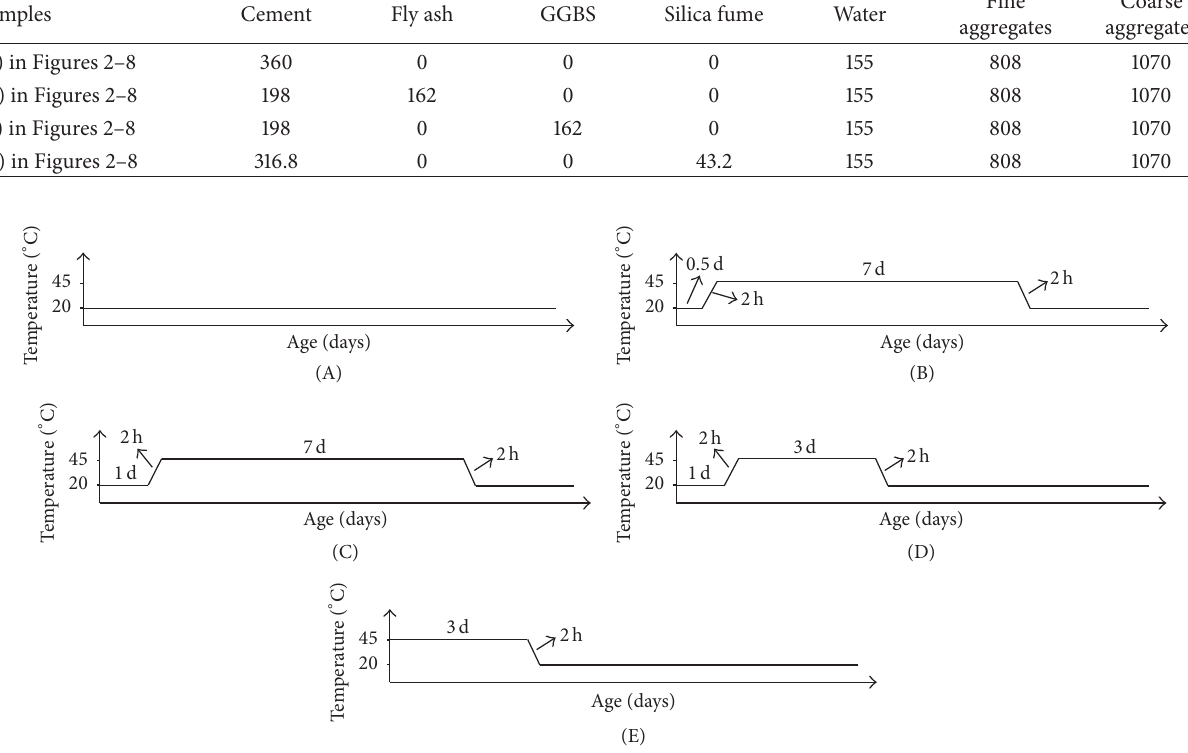
Figure 1: Five different curing conditions. Conditions: (A) under standard curing condition for the whole age; (B) under standard curing condition for the initial 0.5 d, then at 45 ∘ C for 7 d, and thereafter under standard curing condition until testing age; (C) under standard curing condition for the initial 1d, then at 45 ∘ C for 7d, and thereafter under standard curing condition until testing age; (D) under standard curing condition for the initial 1d, then at 45 ∘ C for 3d, and thereafter under standard curing condition until testing age; (E) immediately at 45 ∘ C for 3 d and then under standard curing condition until testing